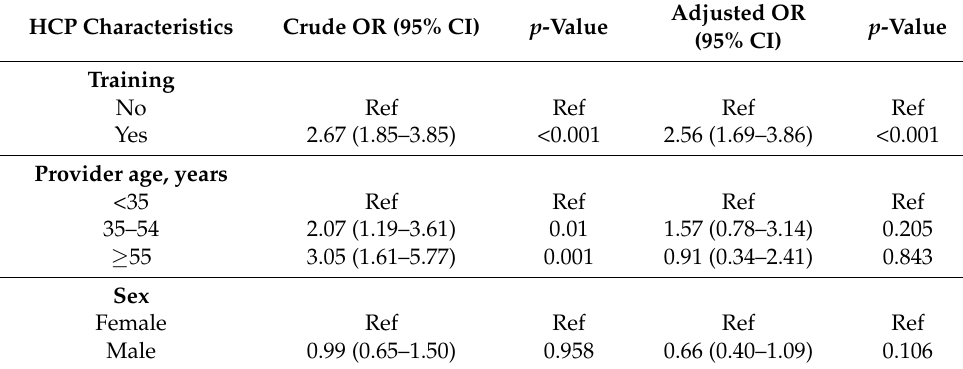
Table 2. Bivariable and multivariable logistic regression analyses of the association between HCPs’ training, socio-demographic, and practice-related factors with HCPs’ perceived self-efficacy in coun- seling HPV vaccine-hesitant parents of pediatric patients (9–18